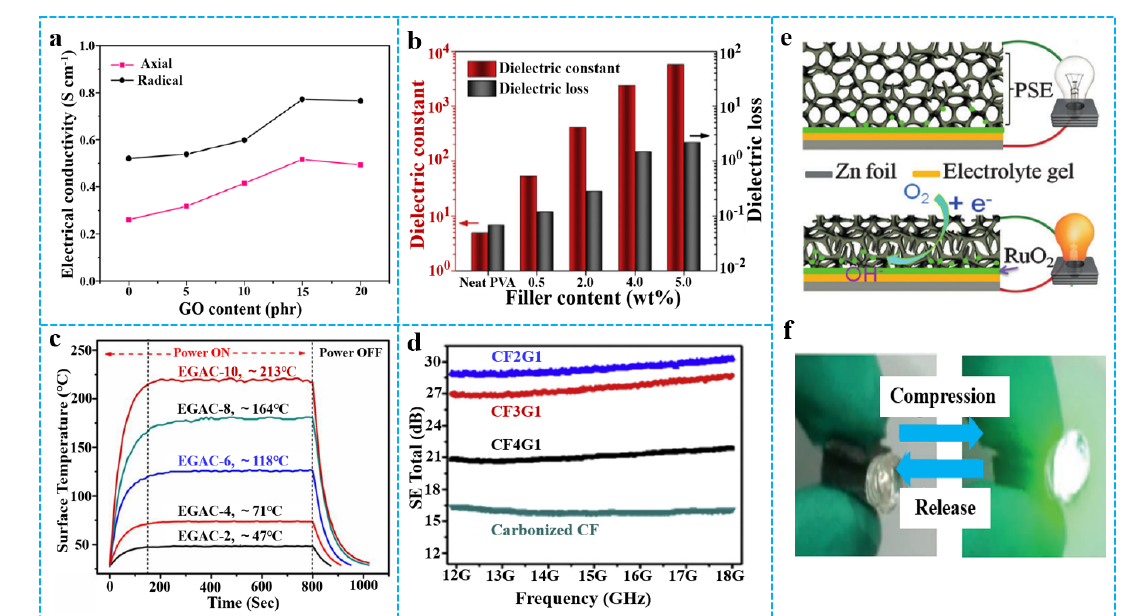
Figure 12. ( a ) Electrical conductivity of PI/graphene aerogels in two directions. Reproduced with permission from [109]. ( b ) Summary of dielectric properties of PVA/graphene aerogel at 1 kHz. Re- produced with permission from [110]. ( c ) Temperature − time response curves of epoxy/graphene- based aerogel composites with different graphene contents. Reproduced with permission from [112]. ( d ) EMI shielding performance of CF/RGO aerogel (5 mm) with different mass ratios in the frequency range from 12 to 18 GHz. Reproduced with permission from [25]. ( e ) Schematic structure and working principle of tactile sensing battery under compression. ( f ) Loading of a compressive force onto a tactile sensing battery increases its output power, illuminating the green LED. Repro- duced with permission from [26].